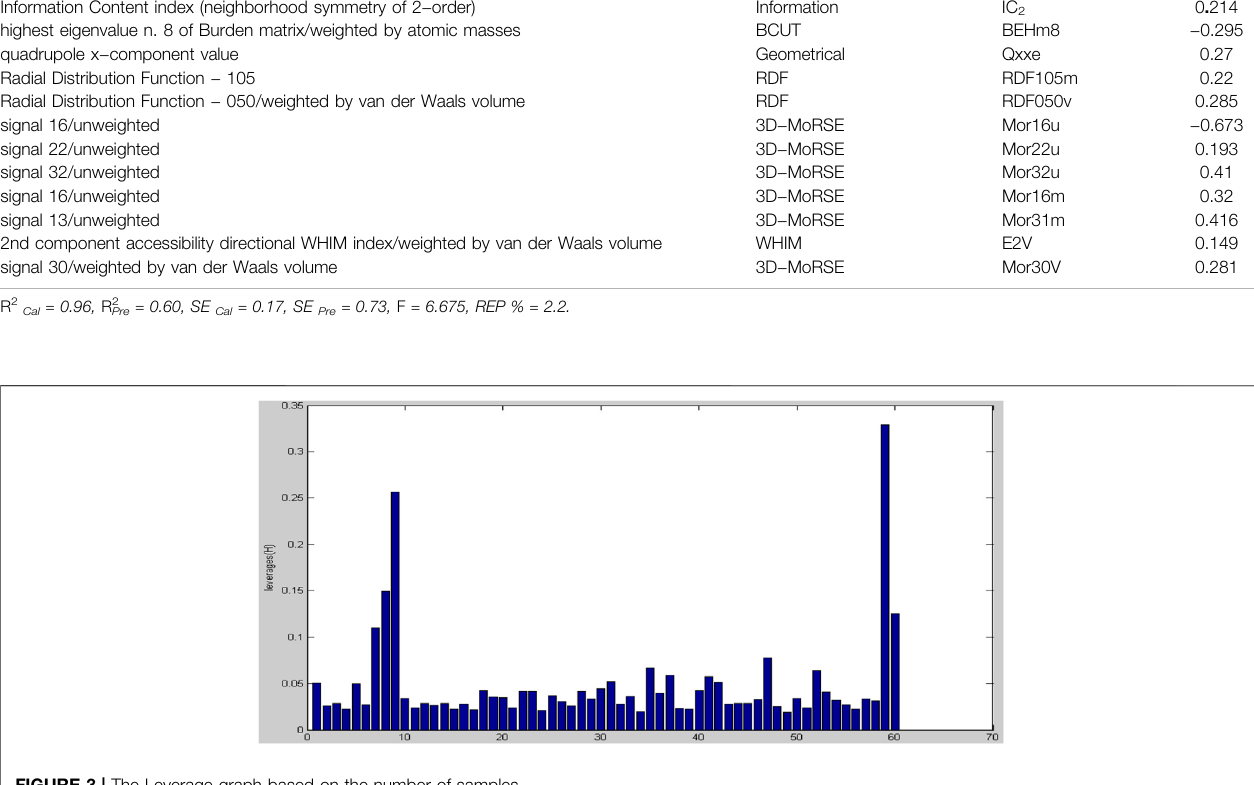
Frontiers in Chemistry |